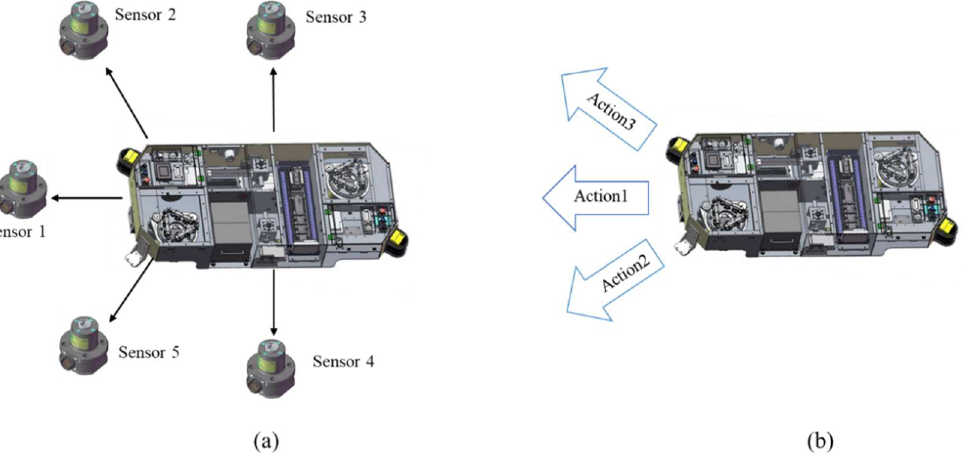
Figure 1. Sensor placement and movement direction. ( a ) shows the position where the sensor is placed, and ( b ) shows the forward direction of AGVs.